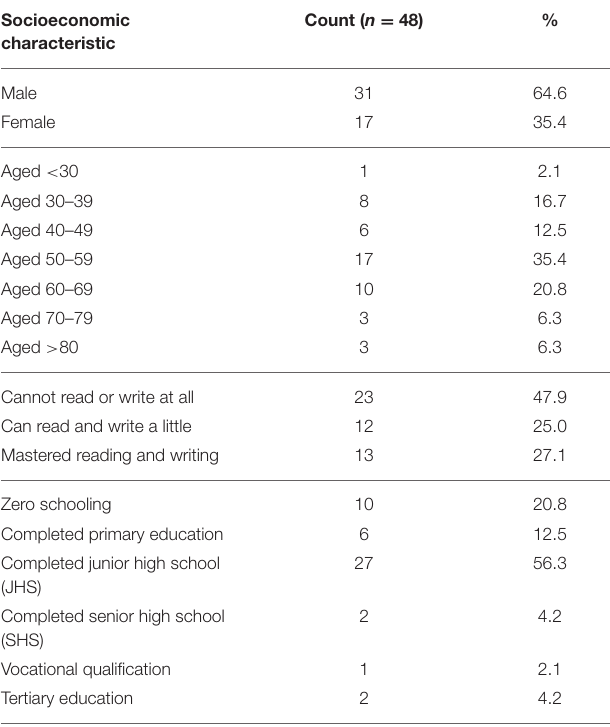
TABLE 1 | The distribution of gender, age, literacy, and formal schooling across the 48 interviewed smallholders. Socioeconomic